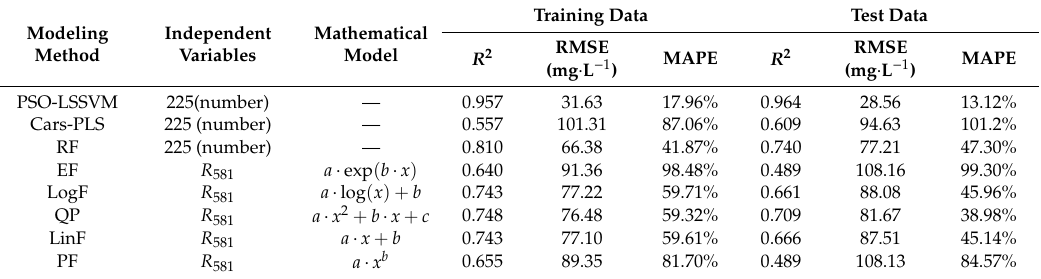
Table 5. Comparison of the di ff erent methods used to build the models for SP